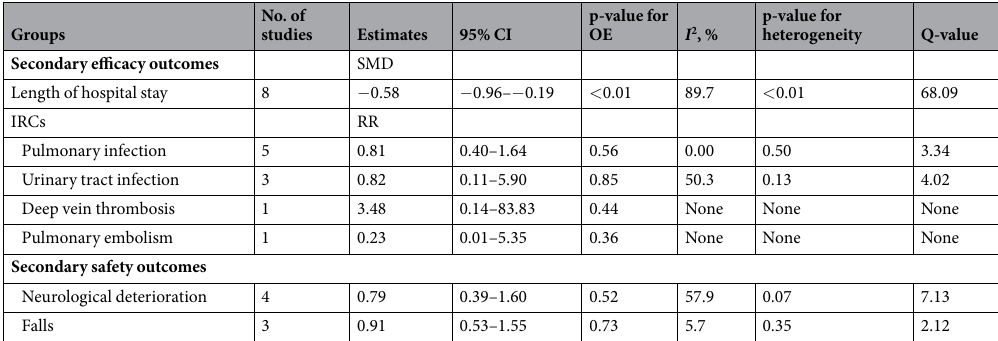
Table 2. Secondary efficacy and safety outcomes. Abbreviations: RR, relative risk; SMD, standardized mean difference; CI, confidence interval; OE, overall effect; IRC, immobilization-related